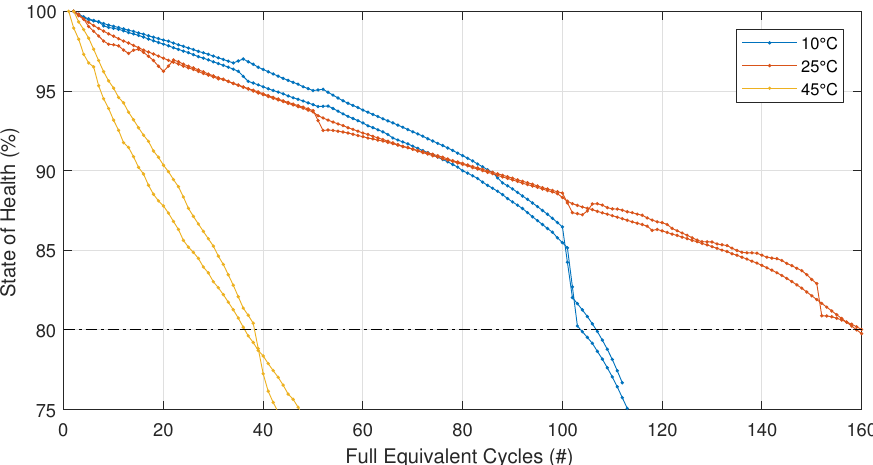
Figure 9. The influence of ambient temperature on capacity retention over Si-alloy battery lifetime, where the black line indicates